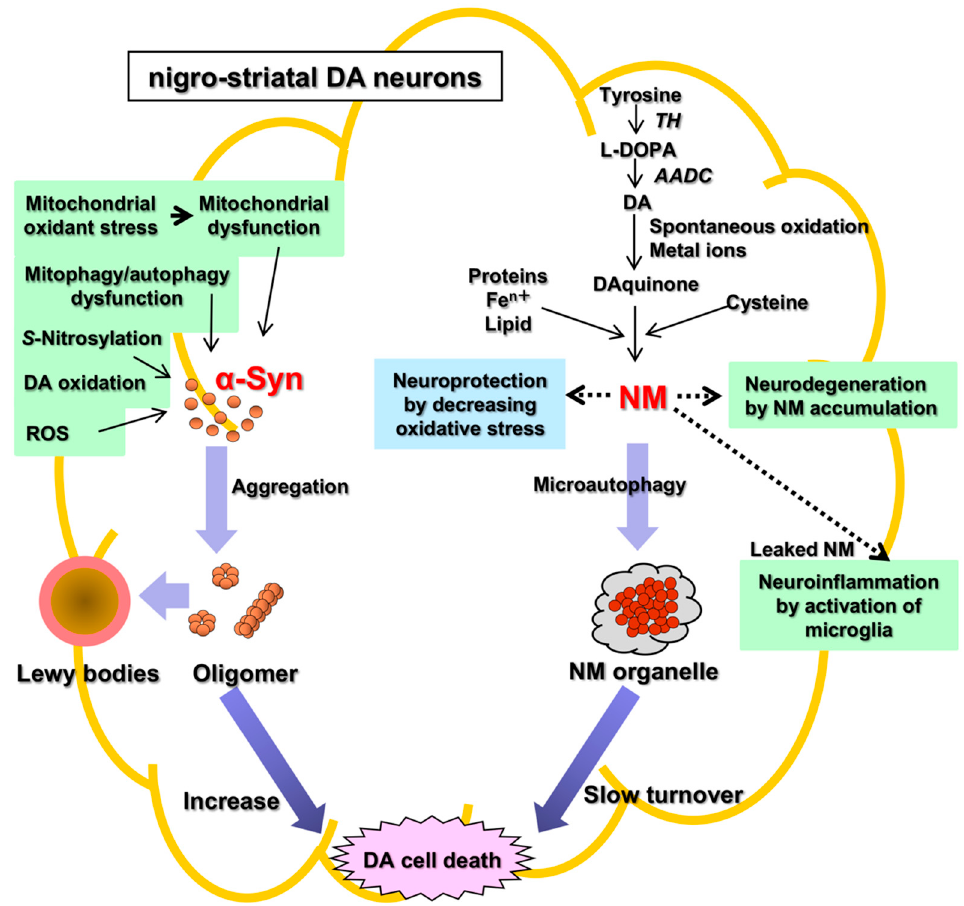
Figure 1. Two histopathological hallmarks in PD in the nigrostriatal DA. Fibrillar oligomers of α -Syn produced by misfolding are presumed to be neurotoxic and to cause DA cell death. Neuromelanin (NM) is also related to neurodegeneration and DA cell death, because NM attenuates the oxidative stress for neuroprotection. α -Syn, α -synuclein; NM, neuromelanin; TH, tyrosine hydroxylase; AADC, aromatic amino acid decarboxylase; ROS, reactive oxygen species.